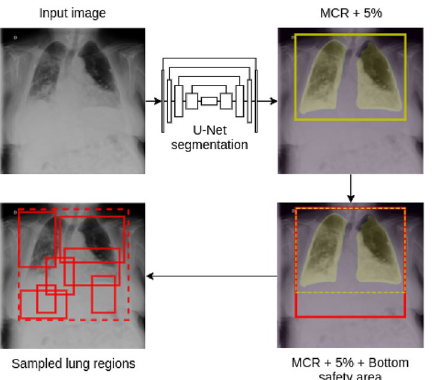
Figure 2. Lung-aware proposal network. First, the lung mask is obtained through a U-net network. The MCR is then calculated and enlarged both by an overall margin of 5% and a bottom margin to get an aspect ratio of 1:1. The final region is used to generate random patches of the original